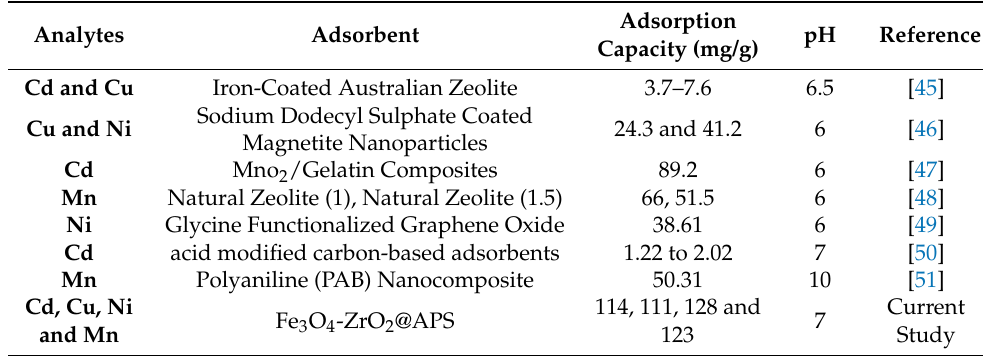
Table 3. Comparison for the removal of Cd, Cu, Mn and Ni by different adsorbents.